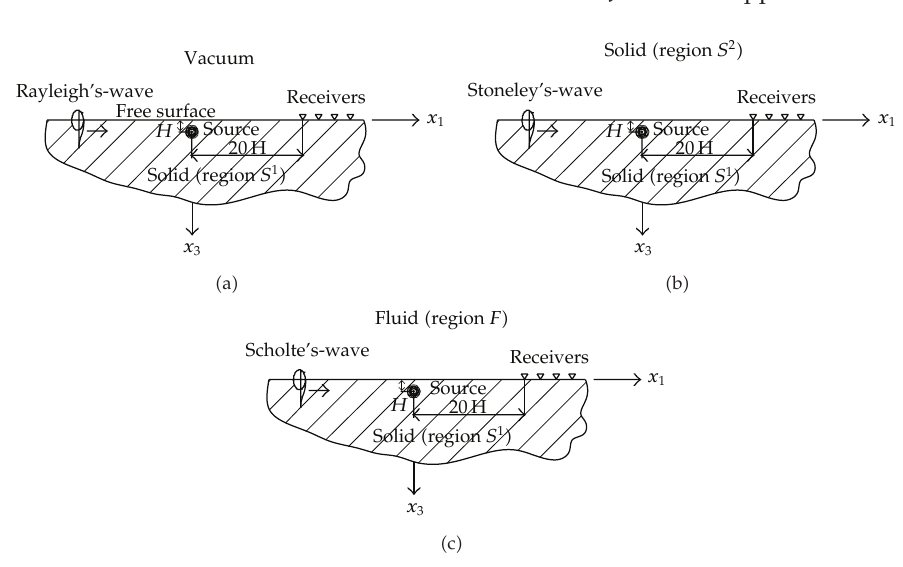
Figure 1: Canonical interface models to be solved by means of the indirect boundary element method. (cid:2) a (cid:5) Vacuum-solid interface, (cid:2) b (cid:5) solid-solid interface, and (cid:2) c (cid:5) fluid-solid interface.